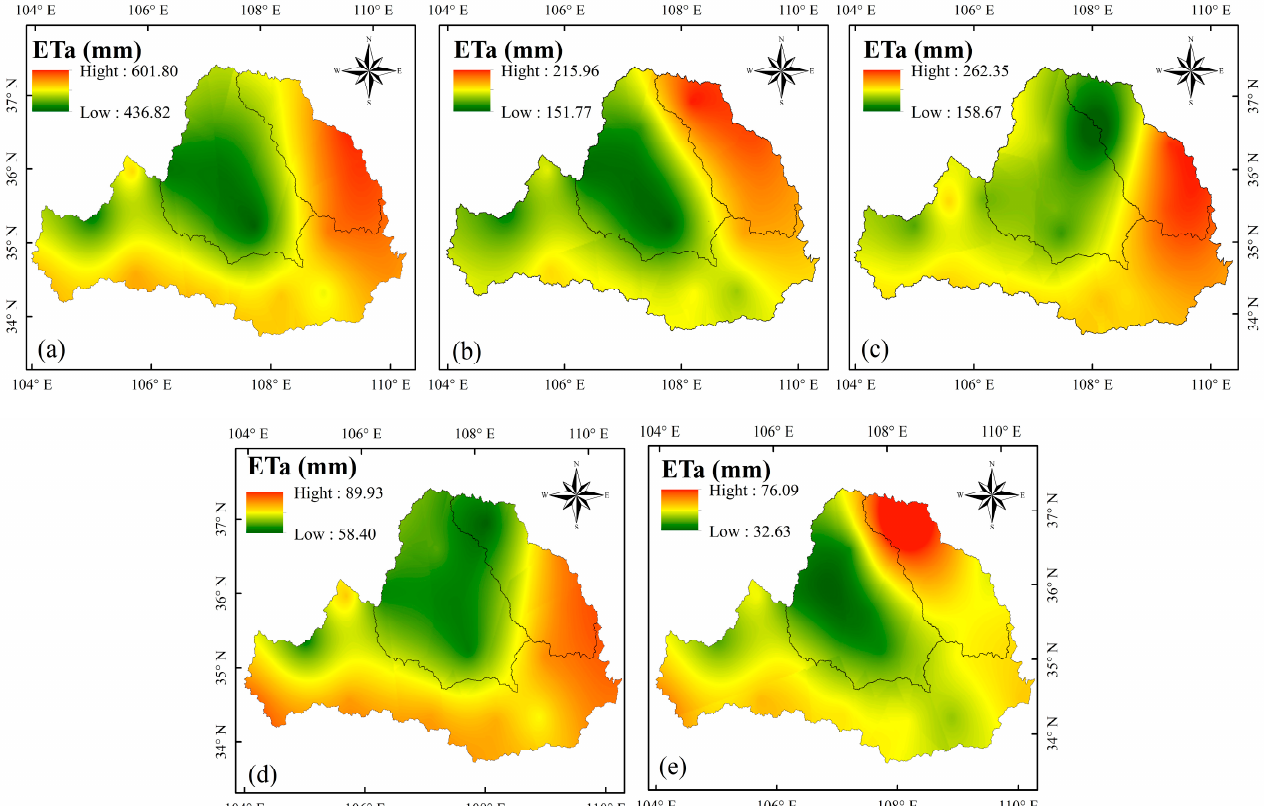
Figure 3. Spatial distribution of annual and seasonal ET a in the Weihe River Basin (( a ): Annual, ( b ): Spring, ( c ): Summer, ( d ): Autumn, ( e ): Winter).